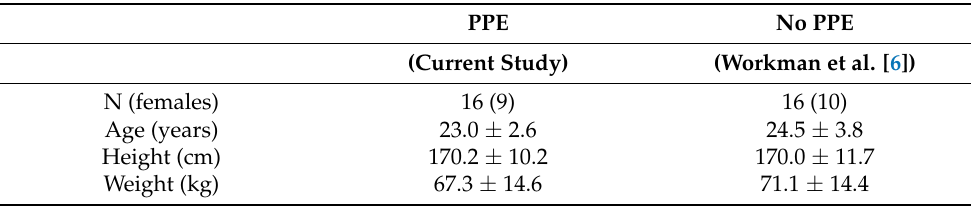
Table 1. Subject characteristics. No PPE from Workman et al., 2020 [6]. Data are mean ±